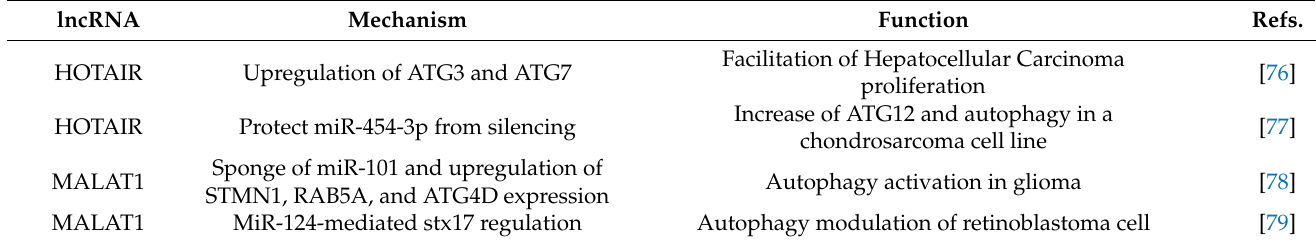
Table 5. Regulation of autophagy by